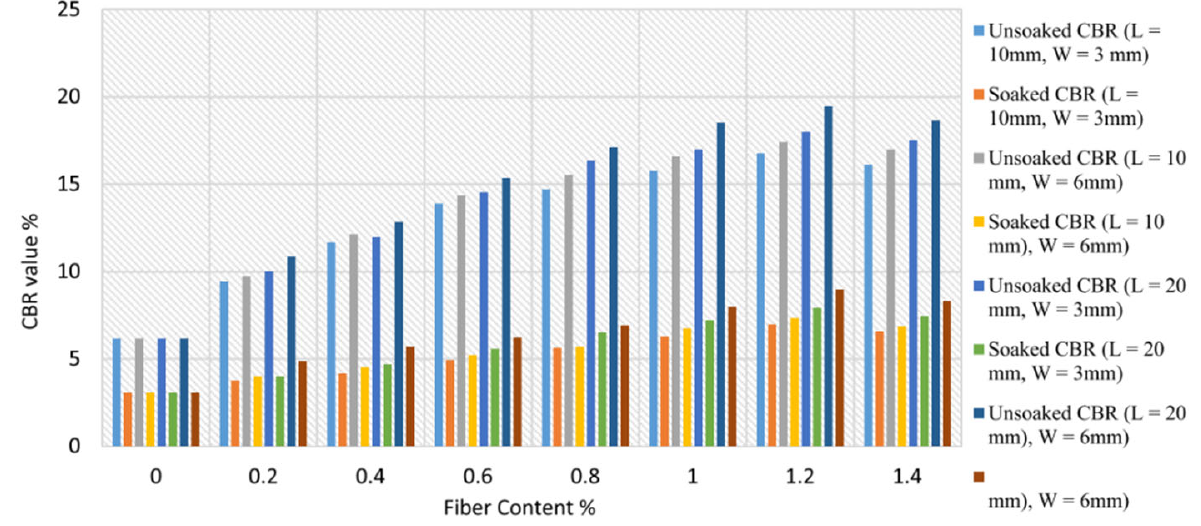
Figure 7: CBR value with different bamboo fiber